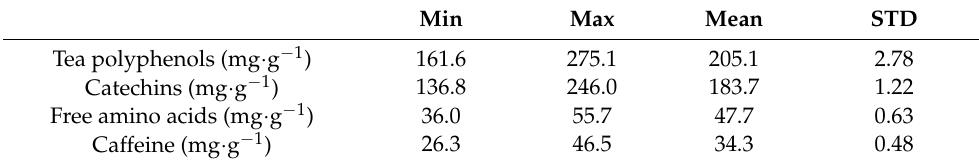
Table 2. Descriptive statistics of the main chemical component concentrations in tea. Min Max Mean